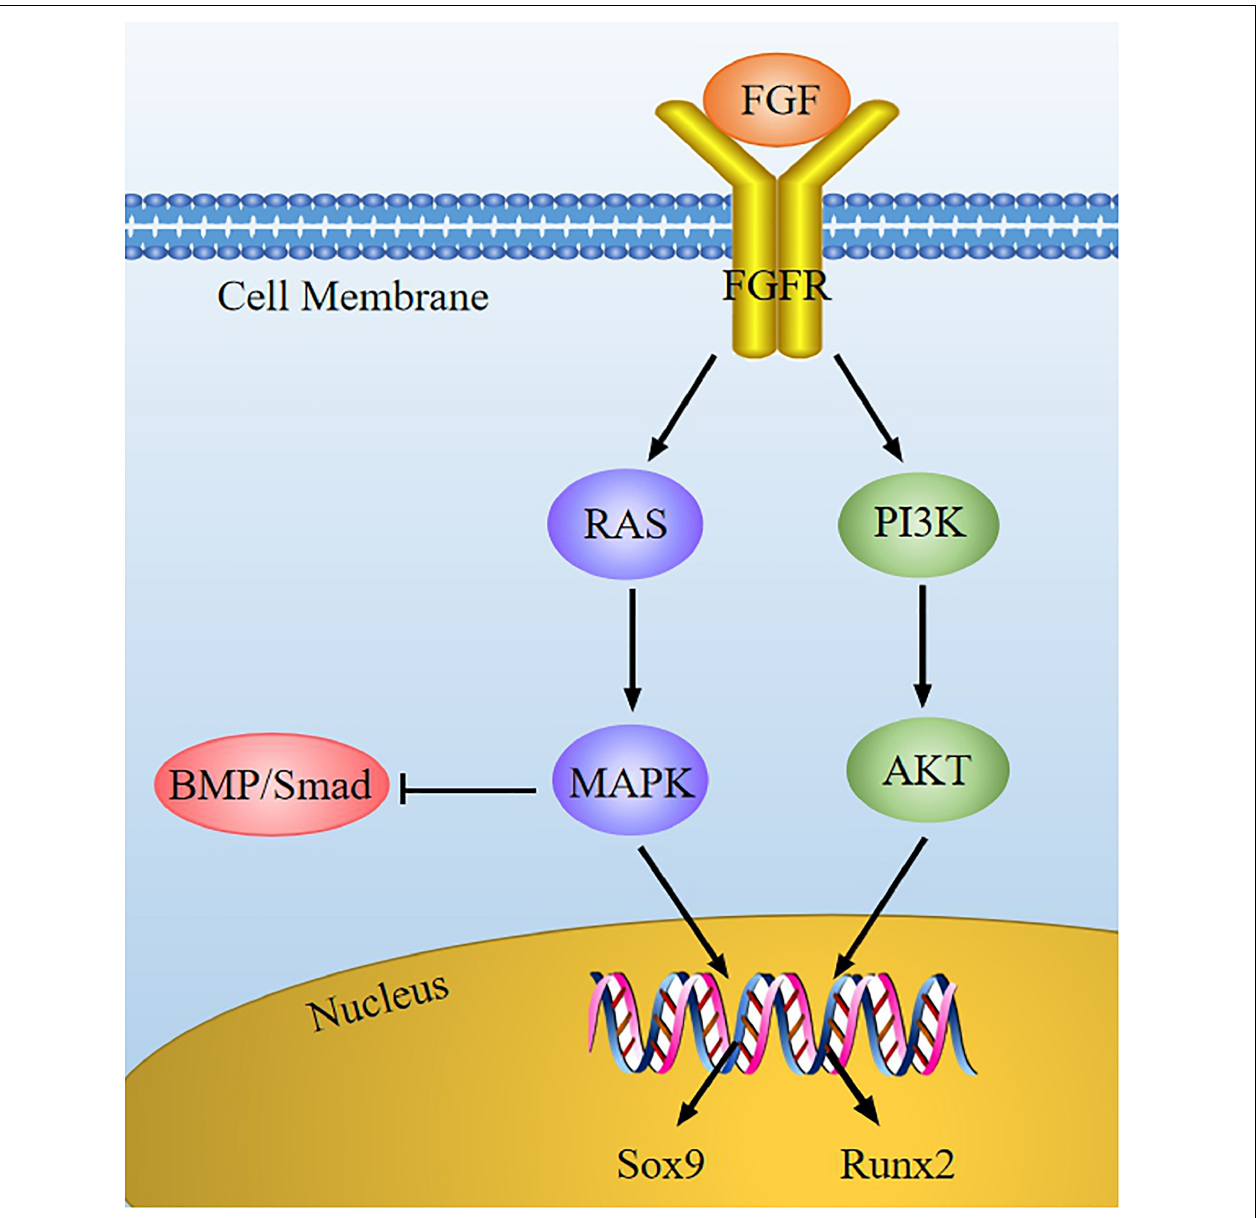
FIGURE 6 | The FGF signaling pathway in chondrocytes. FGF combines with FGFR to activate the downstream cascade (RAS-MAPK and PI3K-AKT), and then the expression of Sox9 and Runx2 is regulated. FGF can suppress BMP/Smad signaling via MAPK signaling in chondrocytes